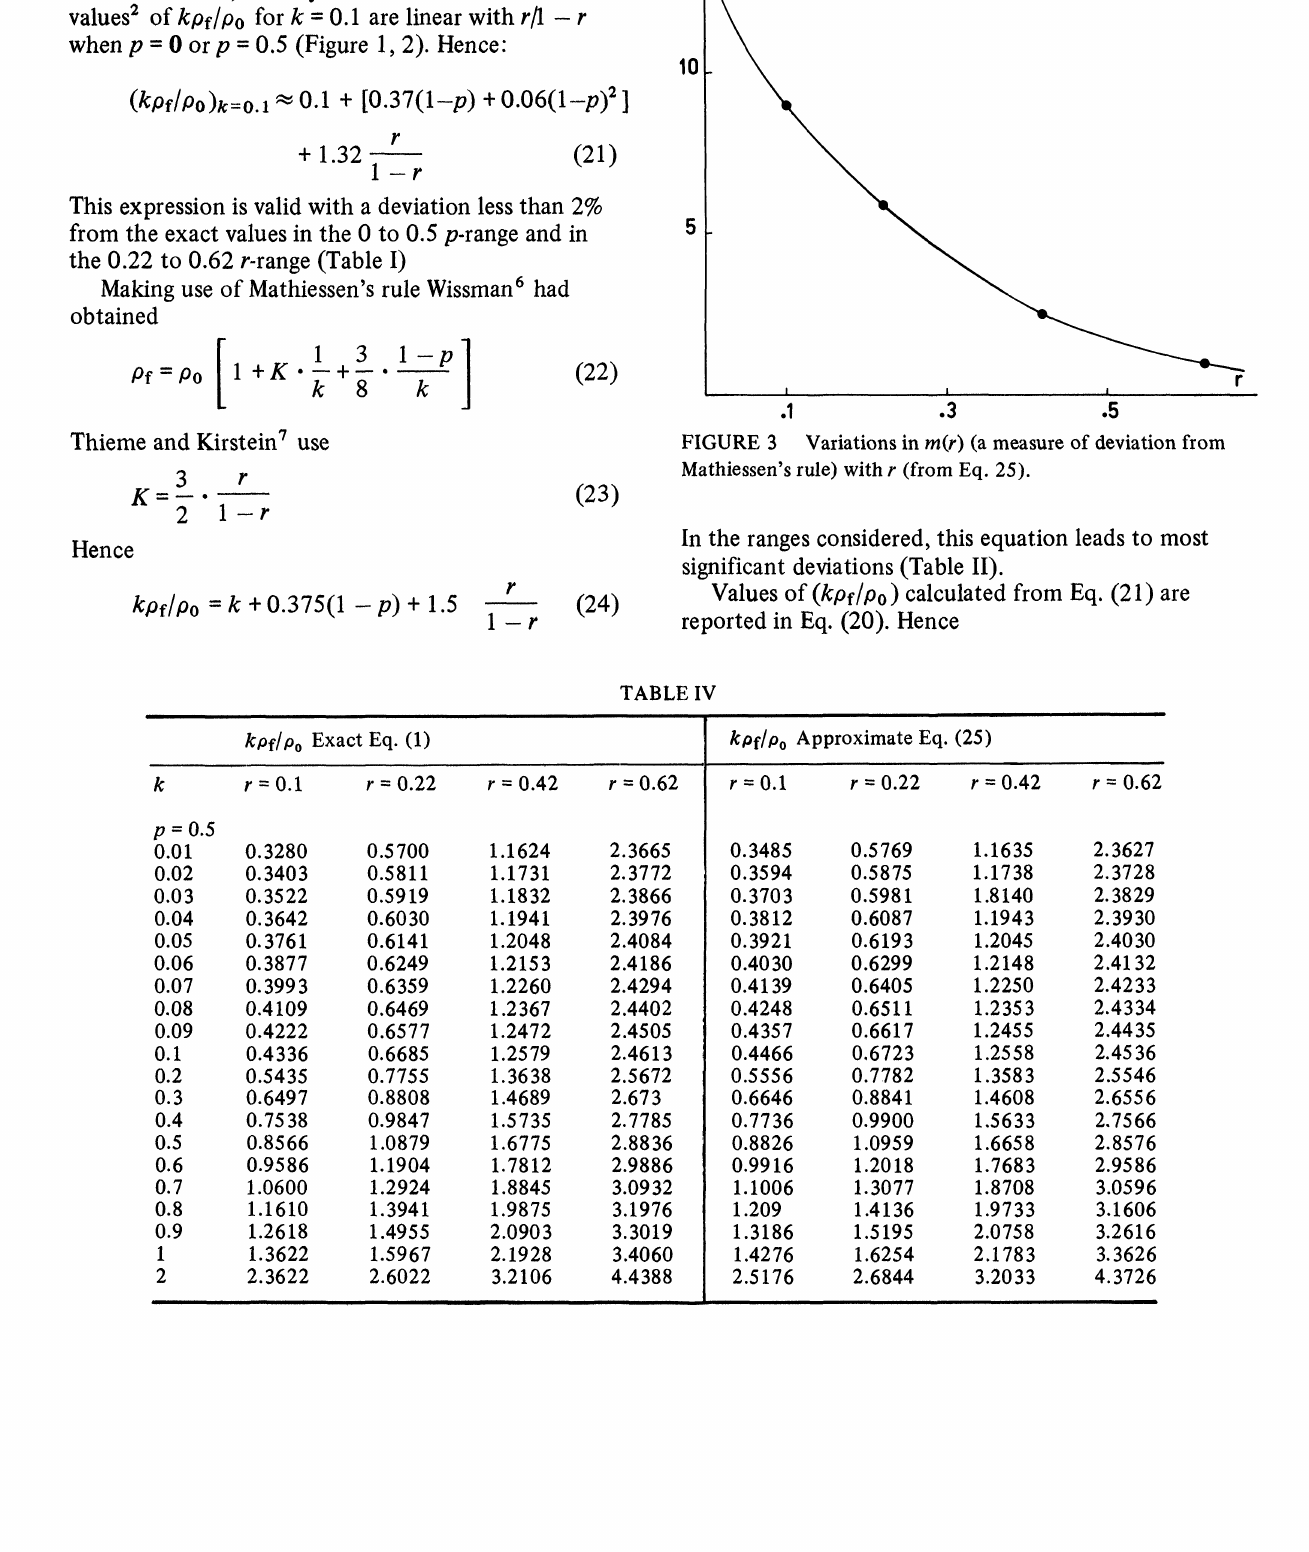
Variations in re(r) (a measure of deviation from Mathiessen’s rule) with r (from Eq.